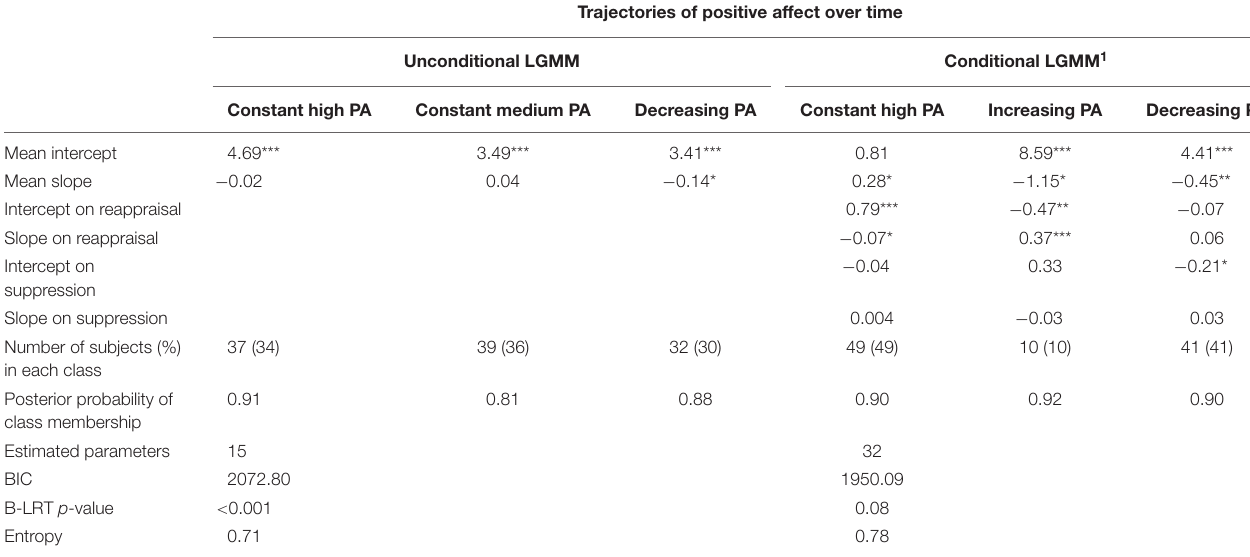
TABLE 3 | Parameters’ estimates, information criteria, and fit indexes for the unconditional and conditional